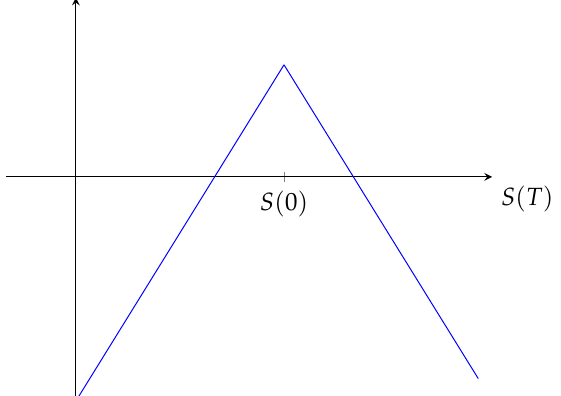
Figure 1. Profit function of a pure short straddle without securing long positions at the money. S denotes the S&P500 index value. The profit/loss (above/below the horizontal axis) depends on the final value S ( T ) of the S&P500 at time T